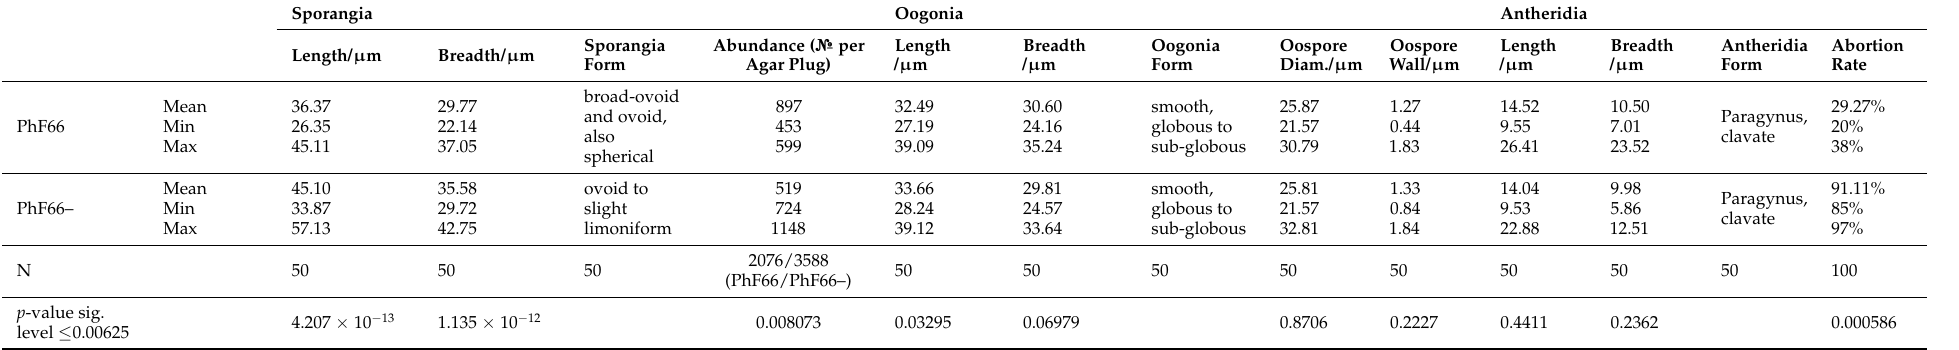
Table 2. Morphological characteristics measured from the virus-free P. cactorum isolate PhF66– and PhF66 containing two